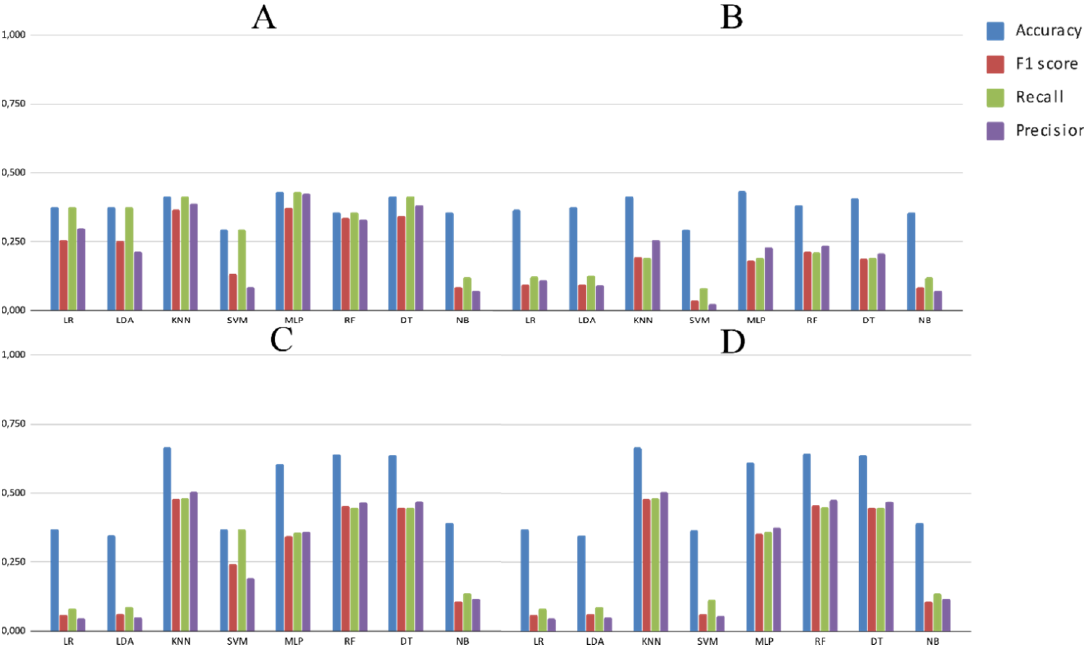
Figure 5. Results of ML algorithms using sequences transformed by PC and PCA and scaling, and